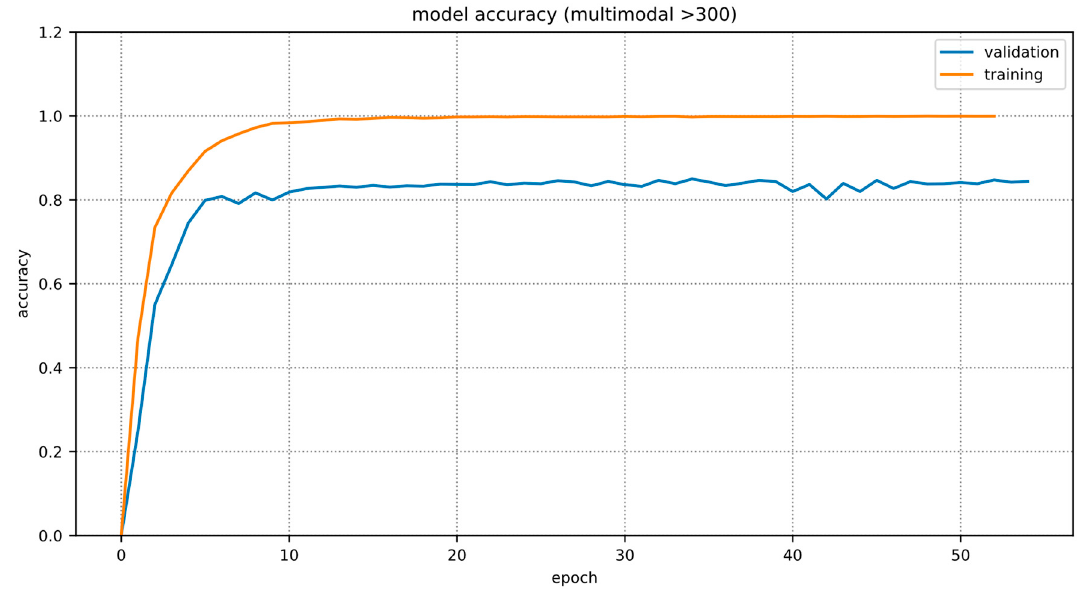
Figure 10. Training and validation accuracy evolution of the multimodal network training on the >300 dataset.